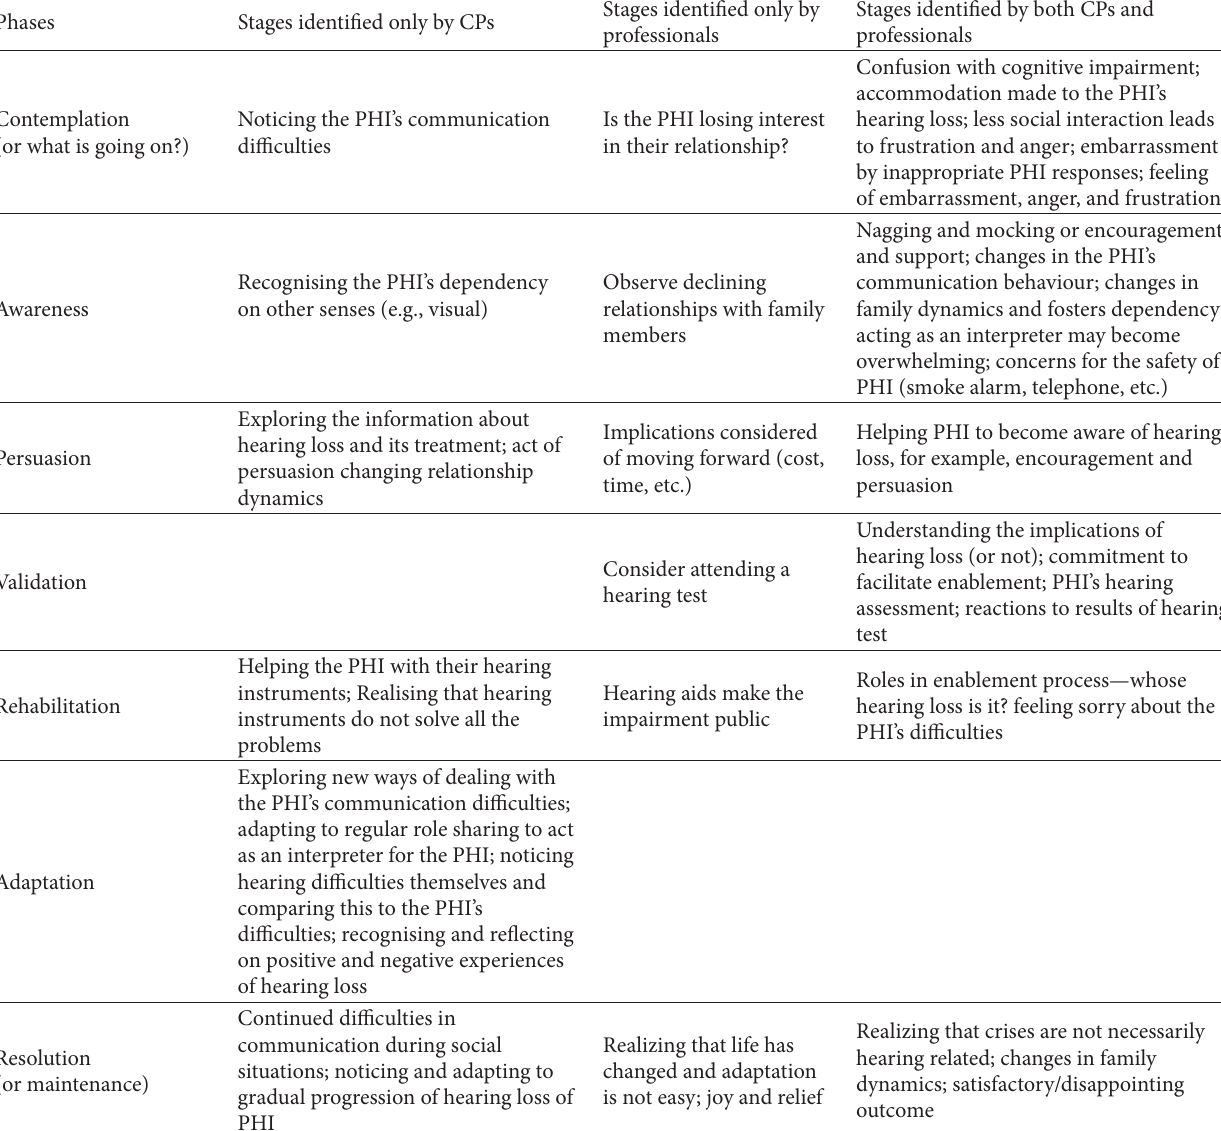
Table 2: Differences and similarities between phases/stages identified by CPs and